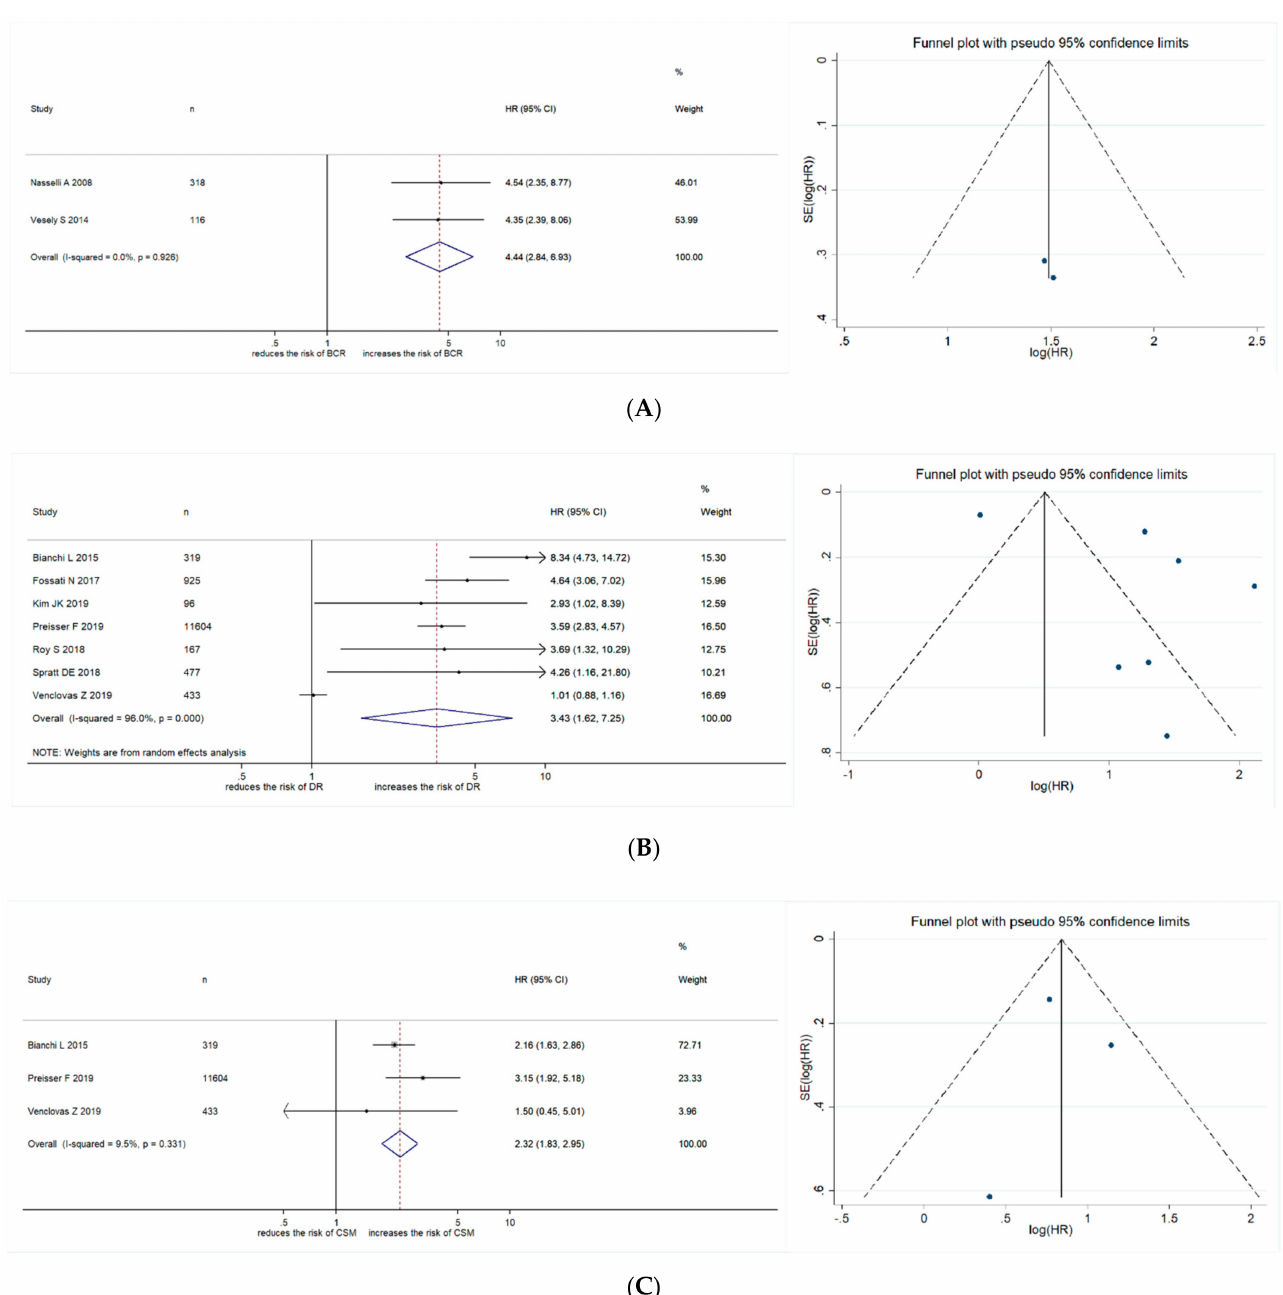
Figure 2. Forest plots and funnel plots showing the association of PSA persistence with ( A ) biochemical recurrence, ( B ) disease recurrence and ( C ) cancer-specific mortality in Prostate Cancer patients treated with radical